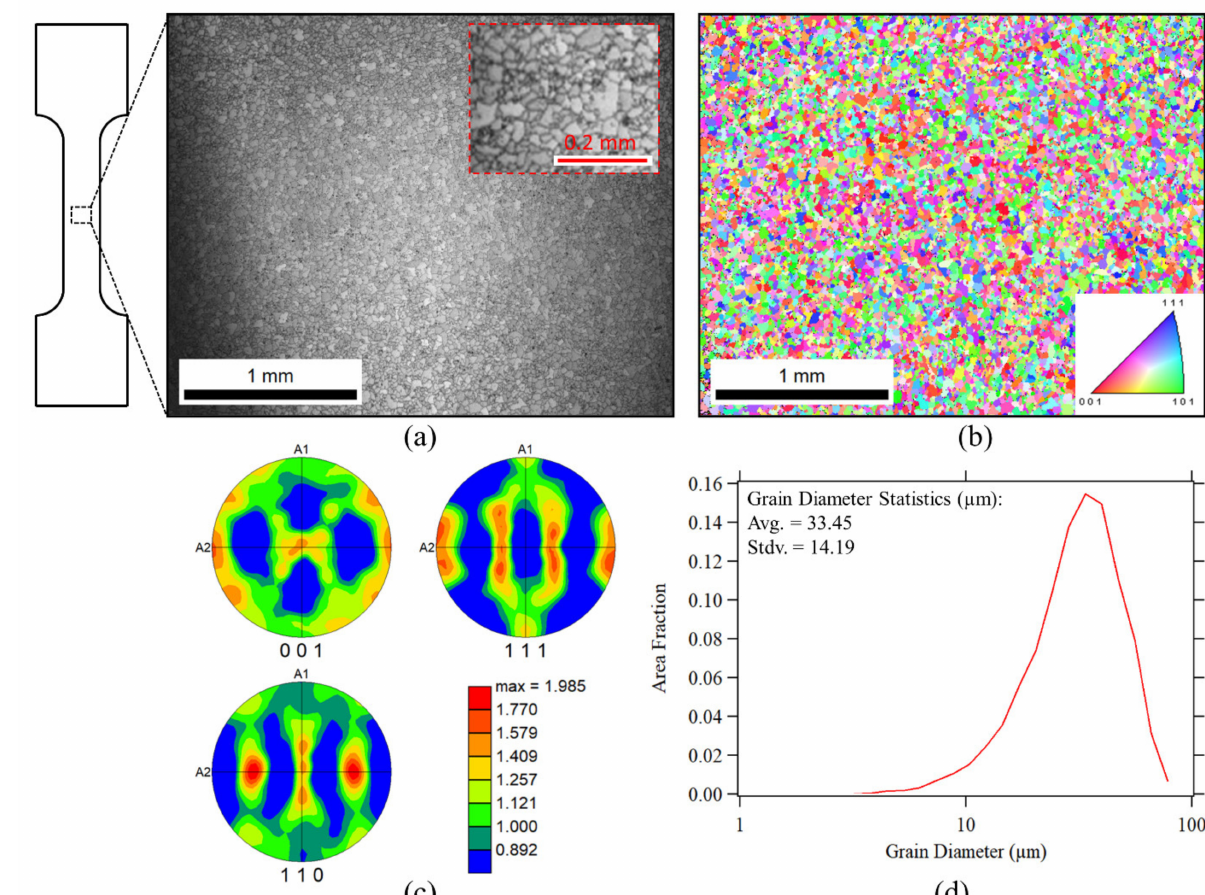
Figure 1. Characterization of AA 5083-H111 aluminum sheets. ( a ) SEM micrograph showing the initial microstructure of the AA 5083-H111 rolled aluminum sheet; ( b ) Grain orientation map of the region shown in ( a ); ( c ) Pole figure; ( d ) Histogram showing the grain size distribution in the scanned